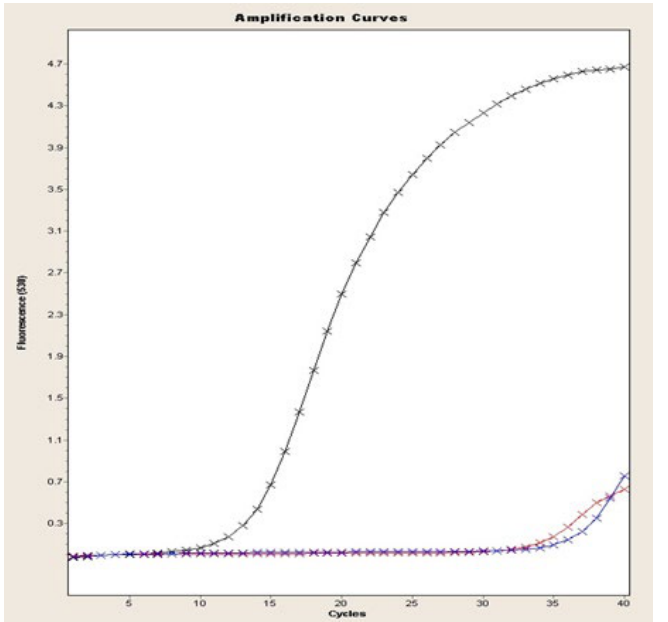
Fig. 4. 16S gene amplification curve, FEND, ITUDI of Bacillus megaterium versus Botrytis sp., at day 5 (LightCycler®,